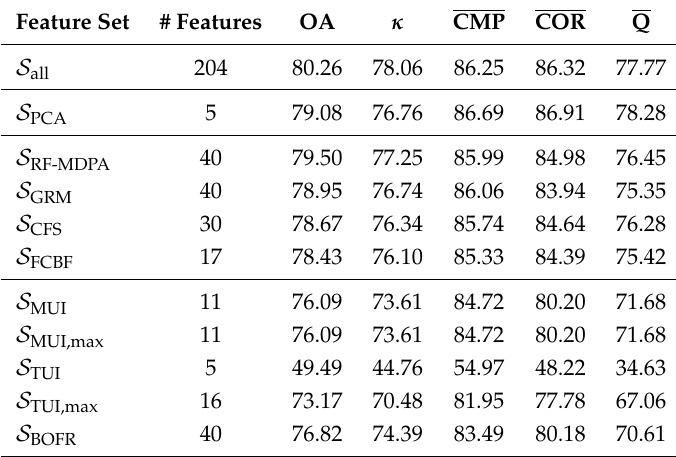
Table 4. Classification results (in %) derived with the Random Forest (RF) classifier for the Salinas dataset (16 classes).